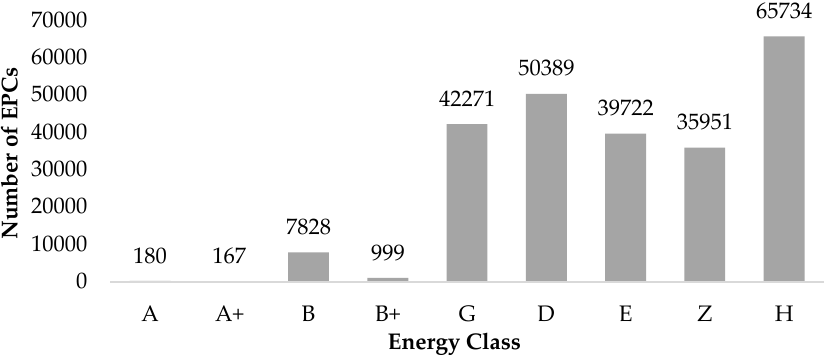
Figure 4. Distribution of EPCs by Energy Class (Source: [53]). The energy performance of buildings is classified according to predetermined energy label classes starting from A+ which corresponds to the most efficient classification, A, B+, B, Γ , ∆ , E, Z to H corresponding to the most energy intensive building category.